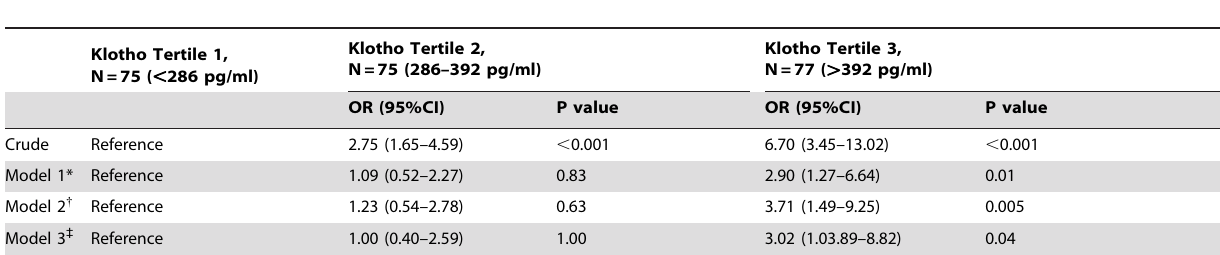
Table 4. Regression analysis for Klotho tertiles with the absence of atrial fibrillation.